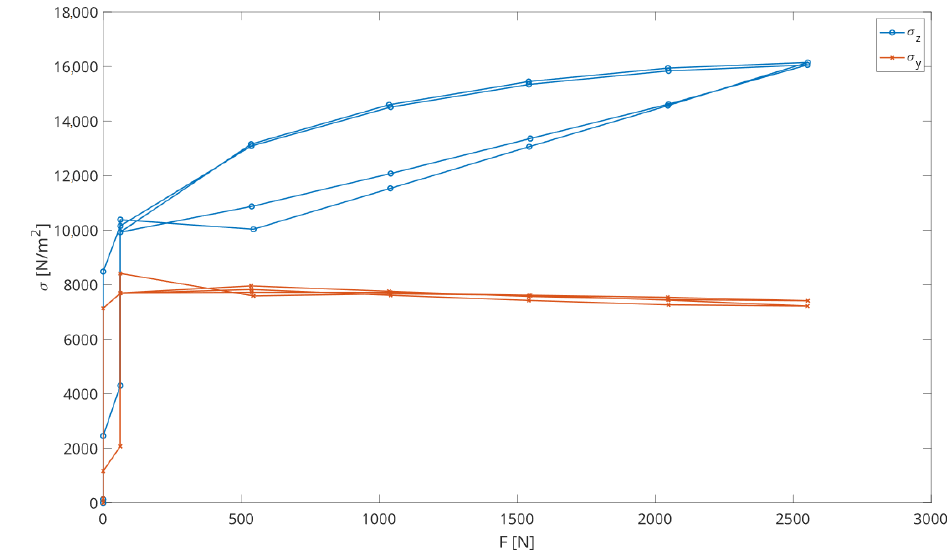
Figure 8. Mean vertical and horizontal pressure depending on the external loading.